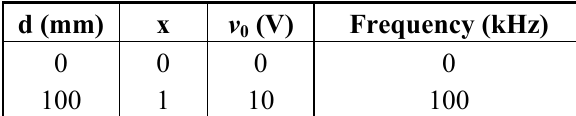
Table 3. Voltage-to-frequency